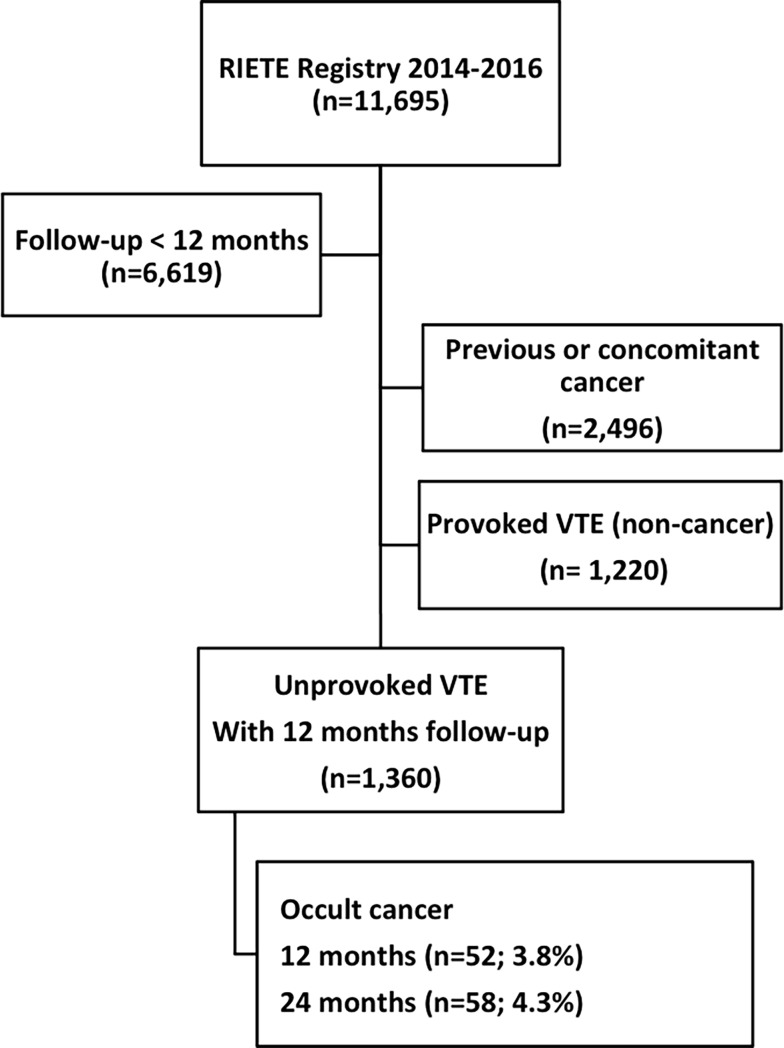
Flowchart patients.